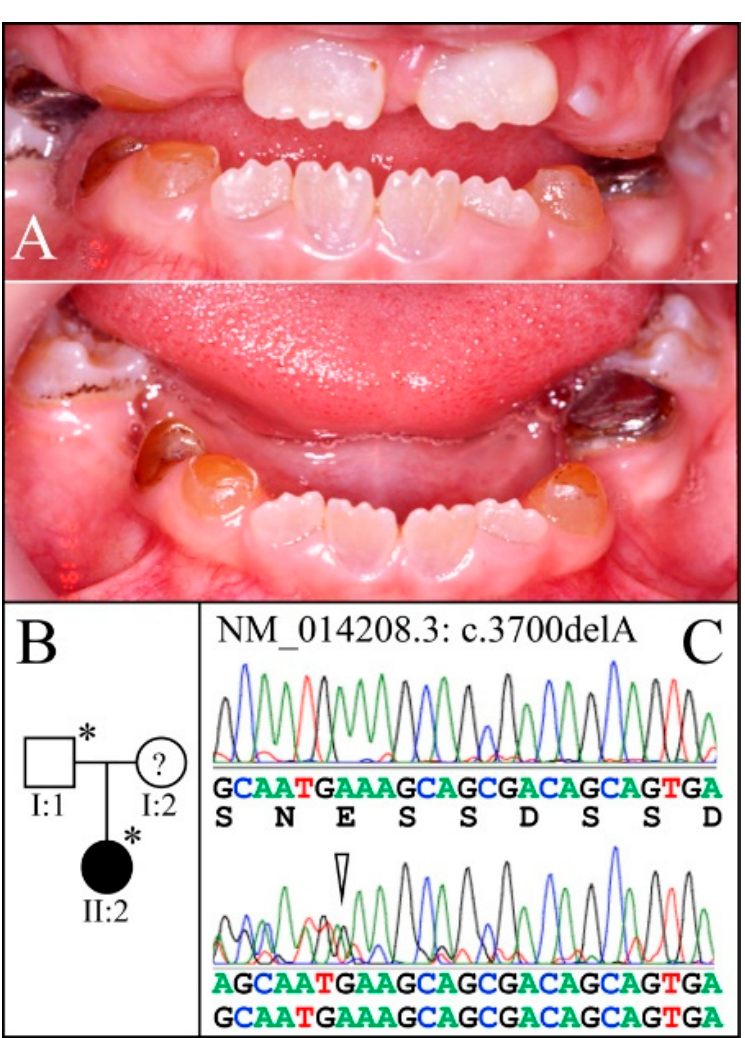
Figure 15. Family 12 from Turkey. Pedigree and proband ′ s phenotype in family with a novel mutation. ( A ): The dental phenotype of the proband (II:2) at age 8-years showed amber-brown, fractured, and shed occlusal enamel, and exposed dentin in primary dentition. The erupted permanent incisors were mildly discolored and opalescent. ( B ): Two-generation pedigree of a family diagnosed with the novel mutation. ( C ): DNA sequence chromatogram showing the novel, disease-causing heterozygous DSPP − 1 frameshift (c.3700delA, p.Ser1234Ala*Ter80) that segregated with the dentin phenotype. Key : * denotes enrolled participants.